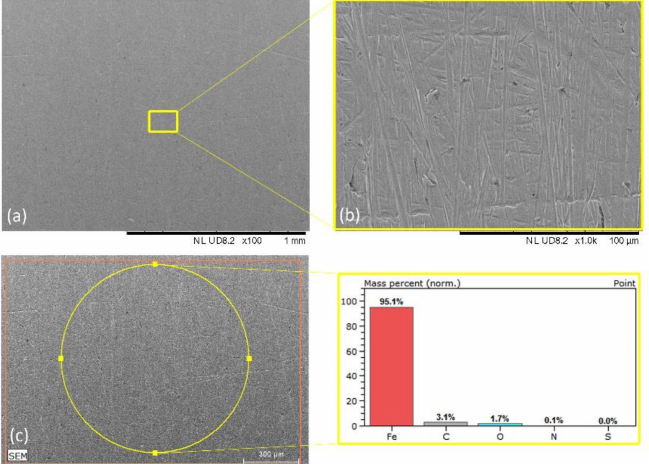
Figure 5. ( a , b ) SEM images and the corresponding ( c ) EDS analysis of mild steel (Mild